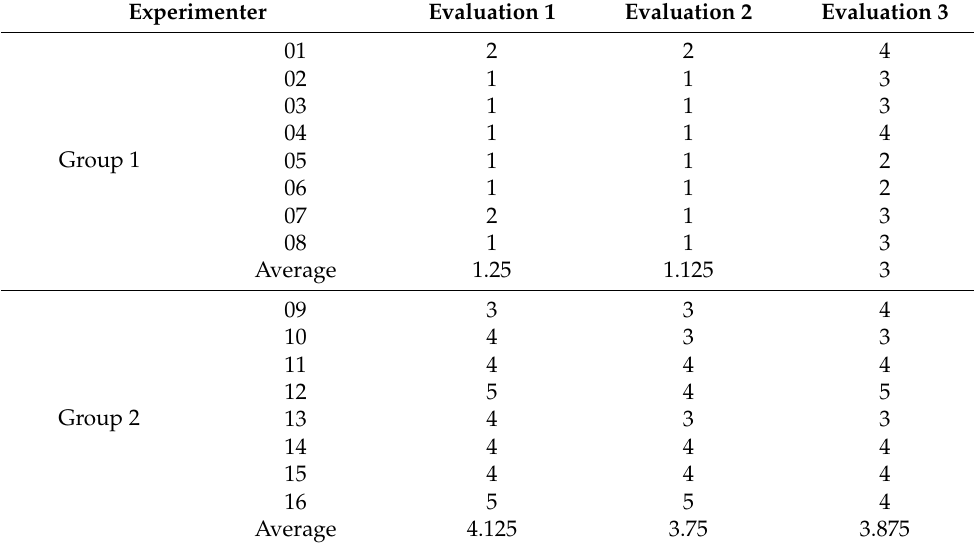
Table 5. Parameters for each